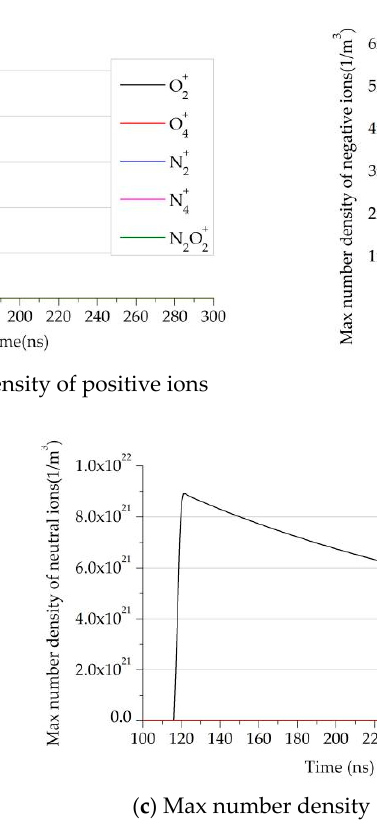
Figure 6. The maximum number density distribution of heavy particles.